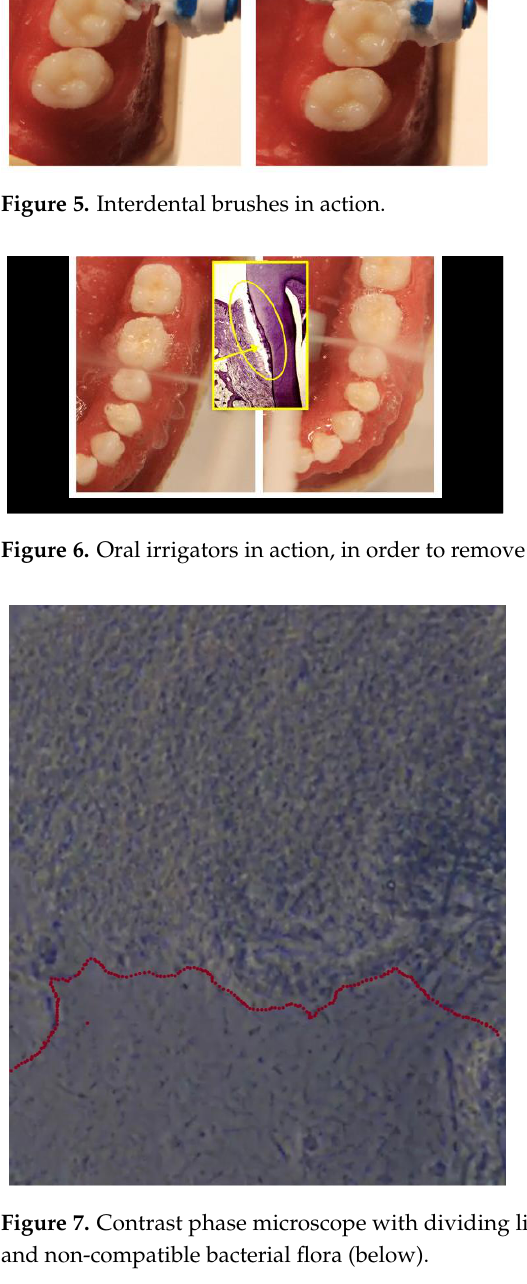
Figure 5. Interdental brushes in action.